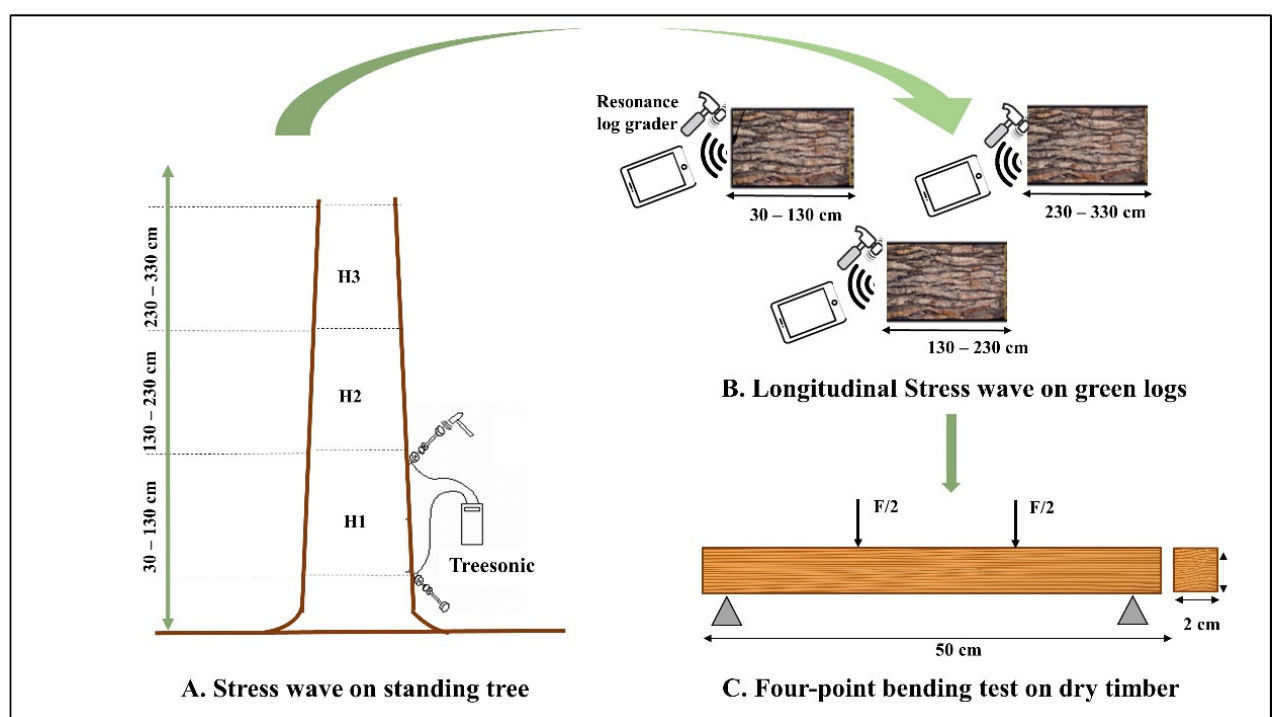
Figure 2. Measurement setup: ( A ) on standing trees; ( B ) on green logs; ( C ) on conditioned specimens.